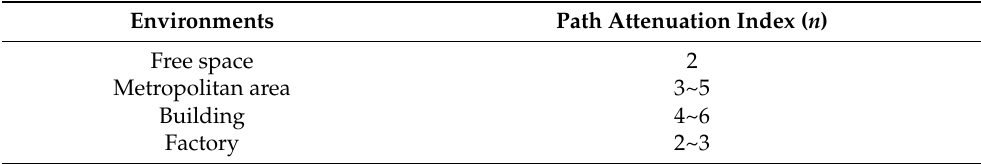
Table 1. Path loss exponent in various